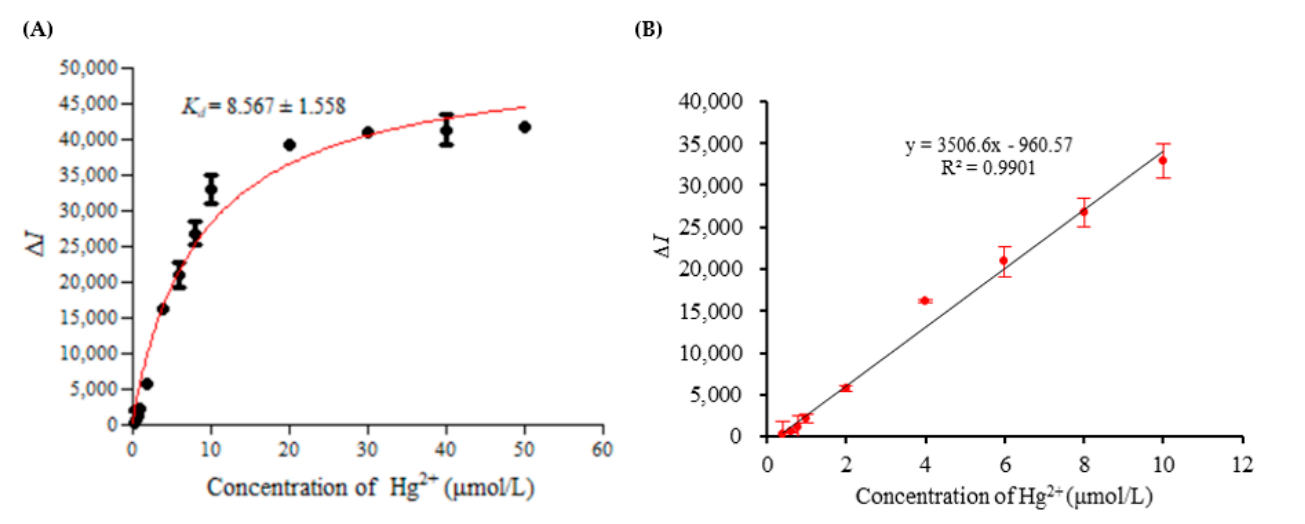
Figure 7. ( A ) The relationship between the fluorescence intensity changes and Hg 2+ concentrations. ( B ) The standard curve. Table 1. Recovery test of Hg 2+ in water